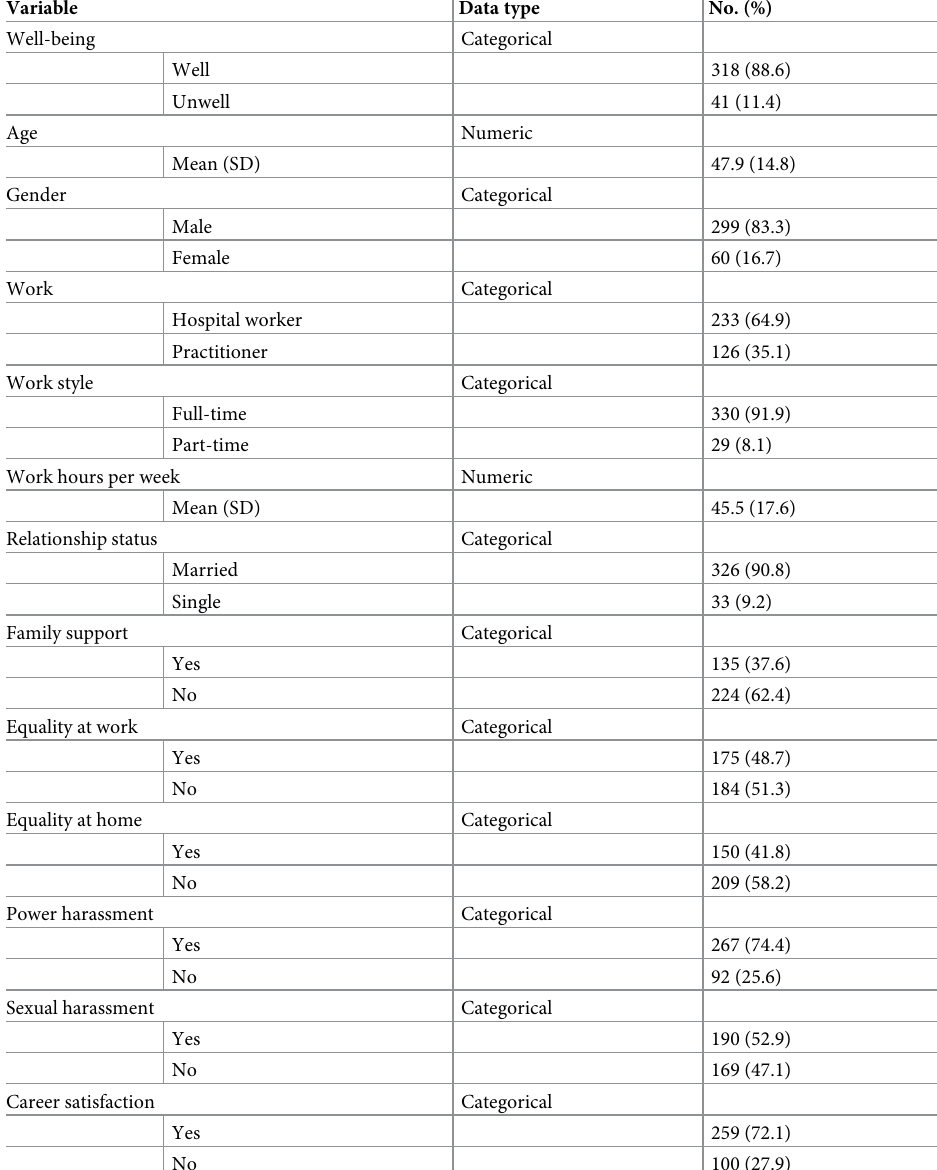
Table 1. Participant characteristics associated with well-being and work–life